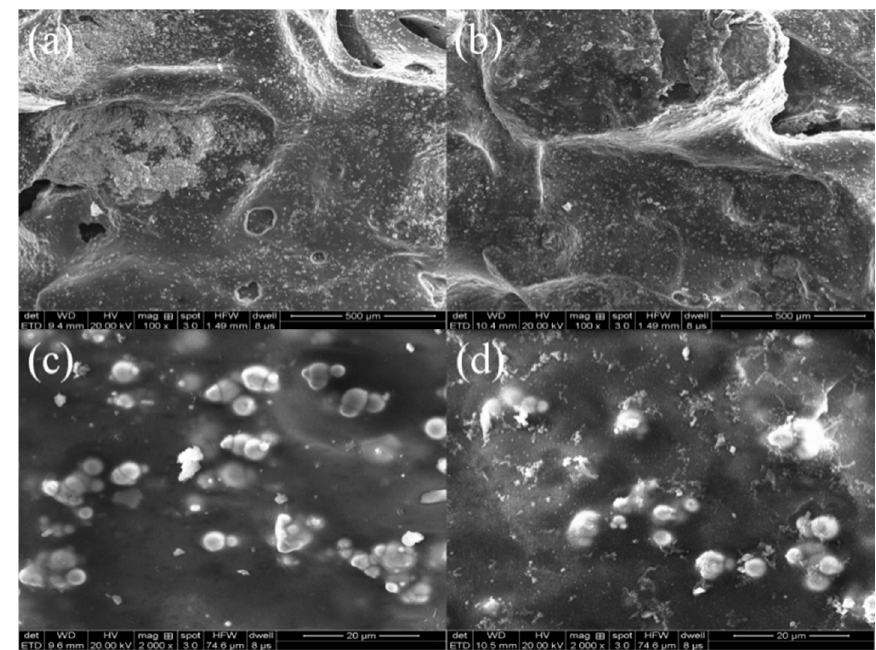
Figure 9. SEM images of the NICLS surface before ( a , c ) and after ( b , d ) the reaction.